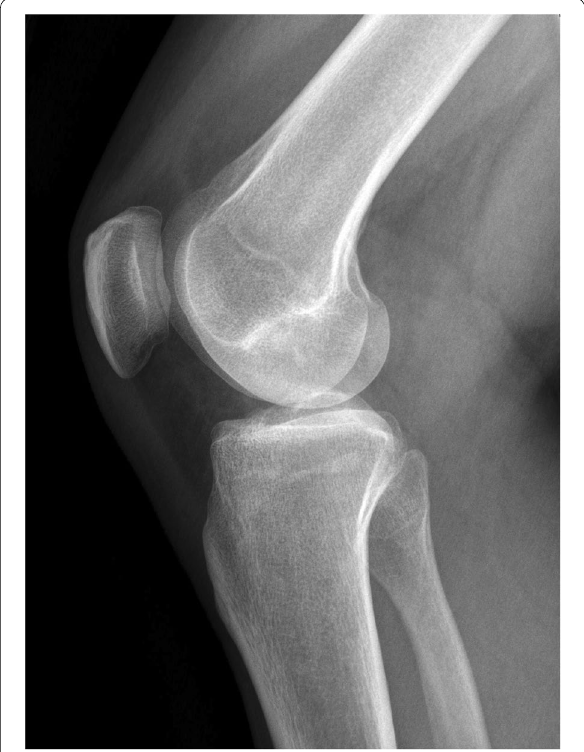
Fig. 6 LAT conventional X‑ray